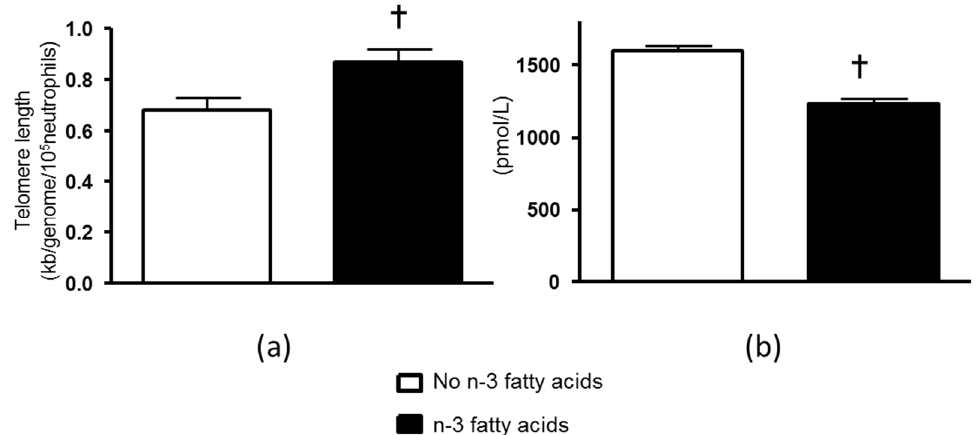
Figure 1. ( a ) Post intervention neutrophil telomere length corrected for neutrophil count and adjusted for baseline values in patients taking n -3 fatty acids compared with those not taking n -3 fatty acids. † p = 0.015 for main effect of n -3 fatty acids post-intervention adjusted for baseline values; ( b ) Post-intervention plasma F 2 -isoprostanes in patients taking n -3 fatty acids compared with those not taking n -3 fatty acids. † p < 0.001 for main effect of n -3 fatty acids post-intervention adjusted for baseline values. Values are means ± SEM.